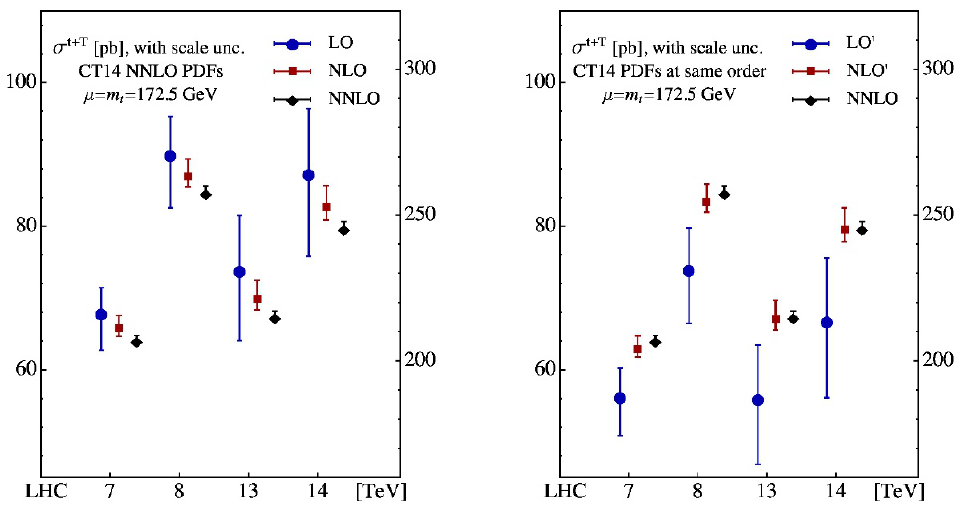
Figure 14 . Sum of inclusive cross sections for t -channel single top quark and anti-quark production, similar to (cid:12)gure